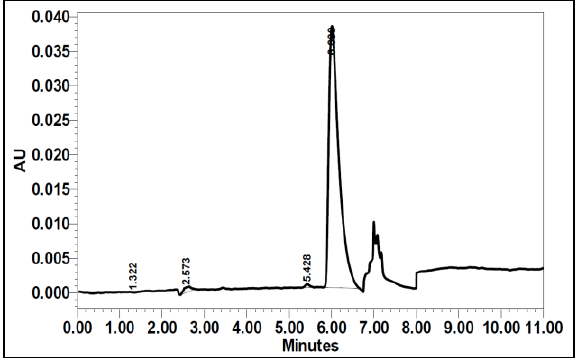
Fig. 7 . HPLC chromatogram of Hexitol ® solution showing a peak of 10.00 µg/ml of CHX at a timed wavelength of 265, 260 & 230 nm.